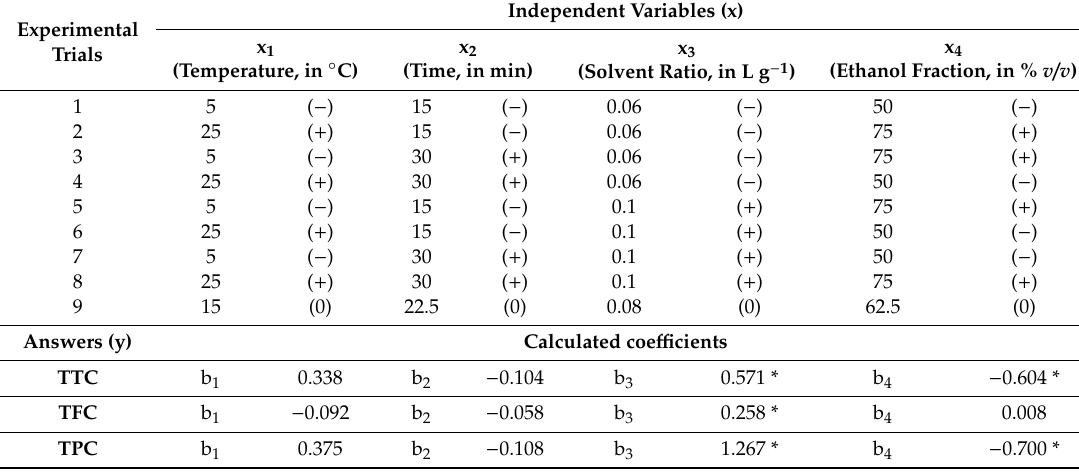
Table 1. Screening fractional factorial design matrix (FFD-2 4 − 1 ) of trials conducted (trials 1 to 9, this last the central point), with the independent variables (x 1 to x 4 ) and answers